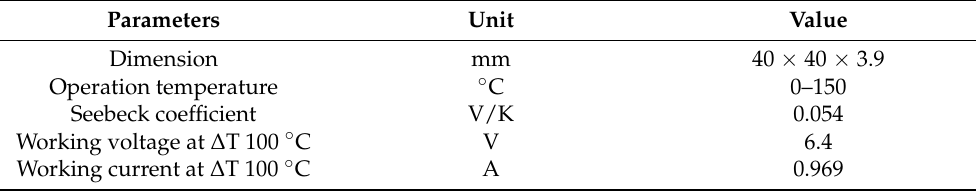
Table 3 . The manufacturer’s specification of the thermoelectric generator .